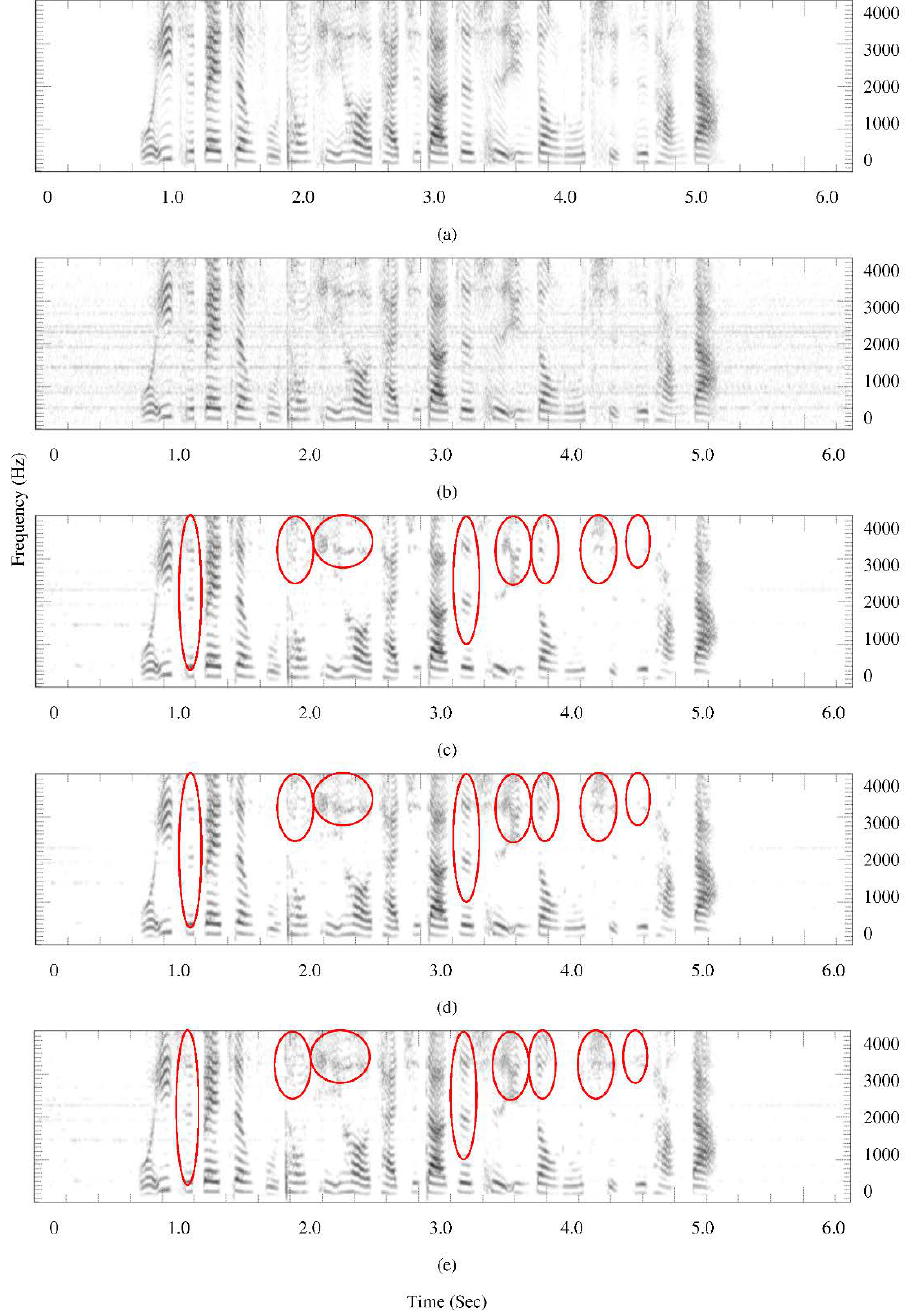
Figure 7. Spectrograms of speech spoken by a female speaker, ( a ) clean speech; ( b ) speech interfered by helicopter-cockpit noise with average SegSNR = 10 dB; ( c ) denoised speech using the MCRA noise estimator; ( d ) denoised speech using the forward-backward MCRA noise estimator; ( e ) denoised speech using the proposed noise